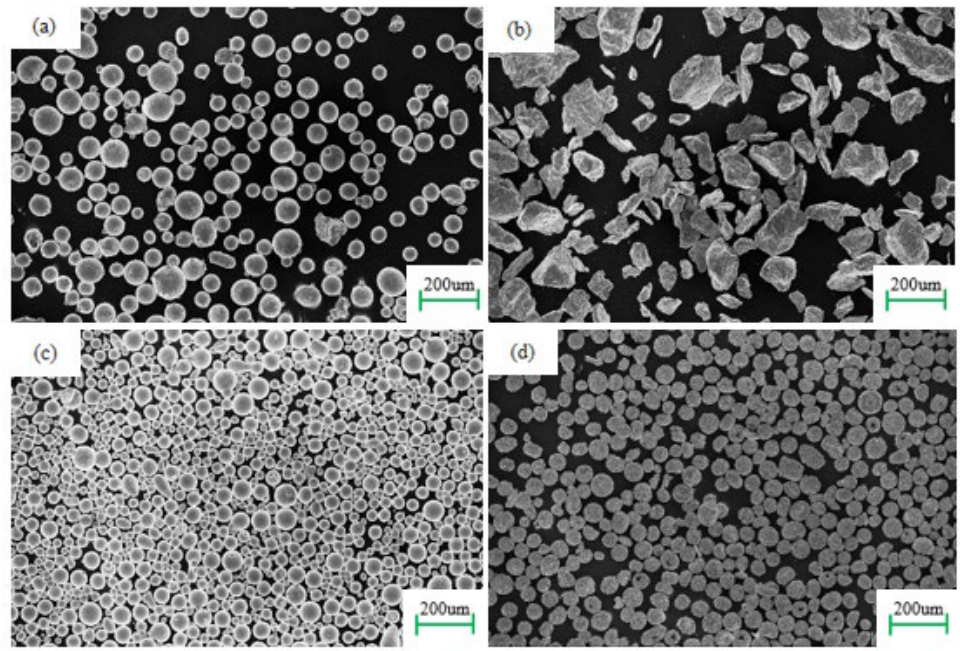
Figure 1. Morphologies of powders used in the coatings ( a ) Co; ( b ) Cr; ( c ) Ni; and ( d ) Mo.